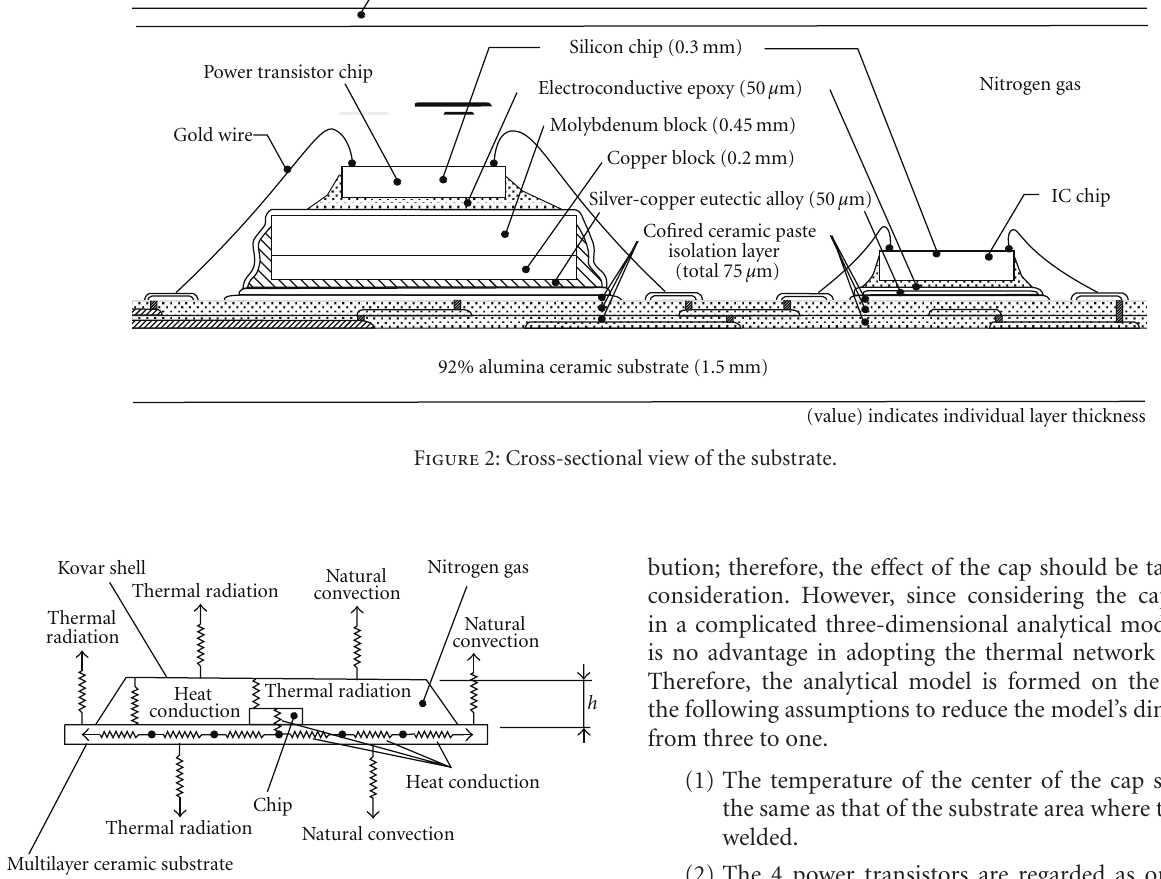
Figure 3: Heat transfer form for